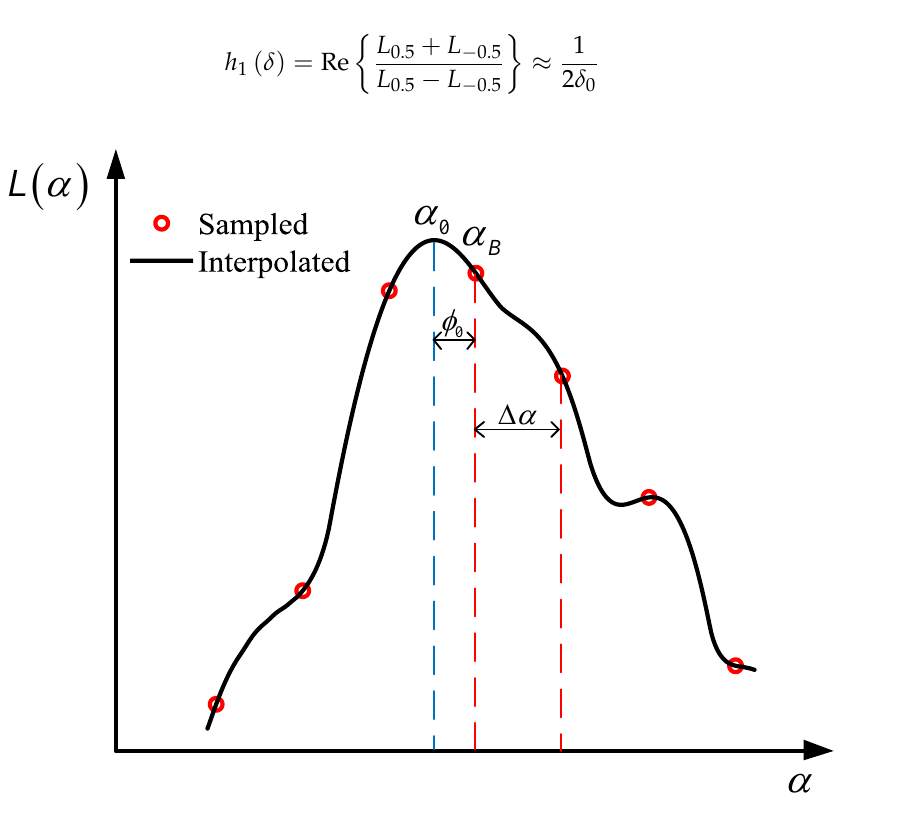
Figure 2. Demonstraction on the effect of the